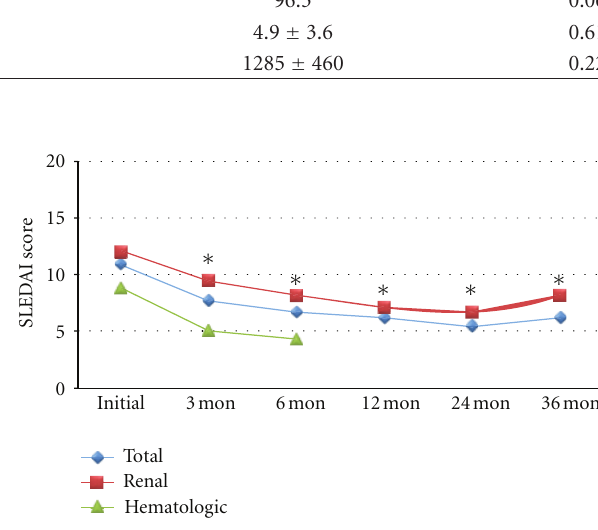
Figure 2: SLEDAI score after RTX treatment in patients with refrac- tory SLE. ∗ P value < 0.05. Table 3: Adverse events in 39 SLE patients receiving